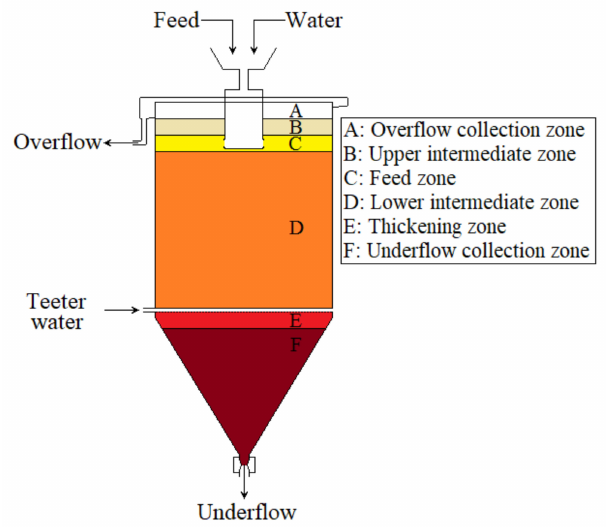
Figure 6. The zones in a hydraulic